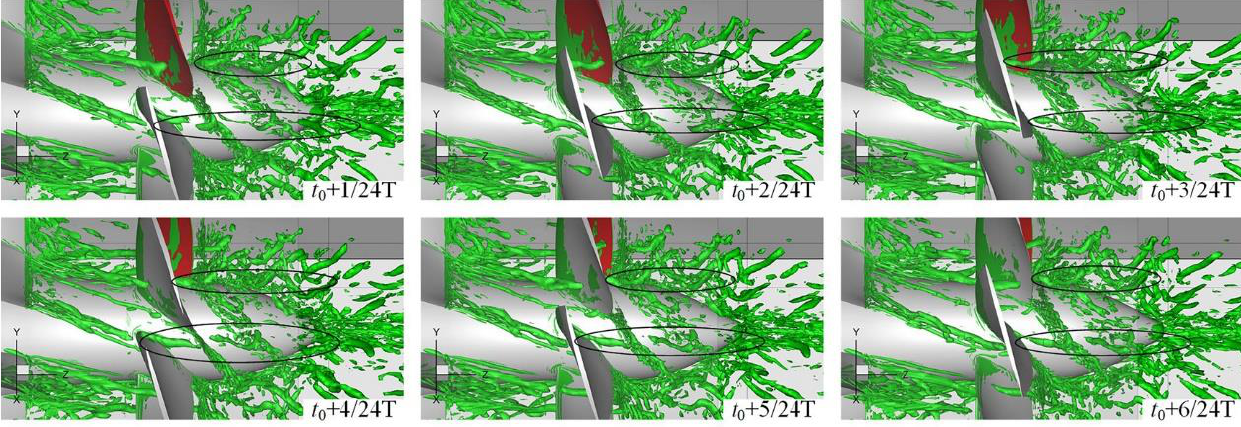
Figure 12. Interaction between the blade root vortices of the stator and rotor at a series of instants.